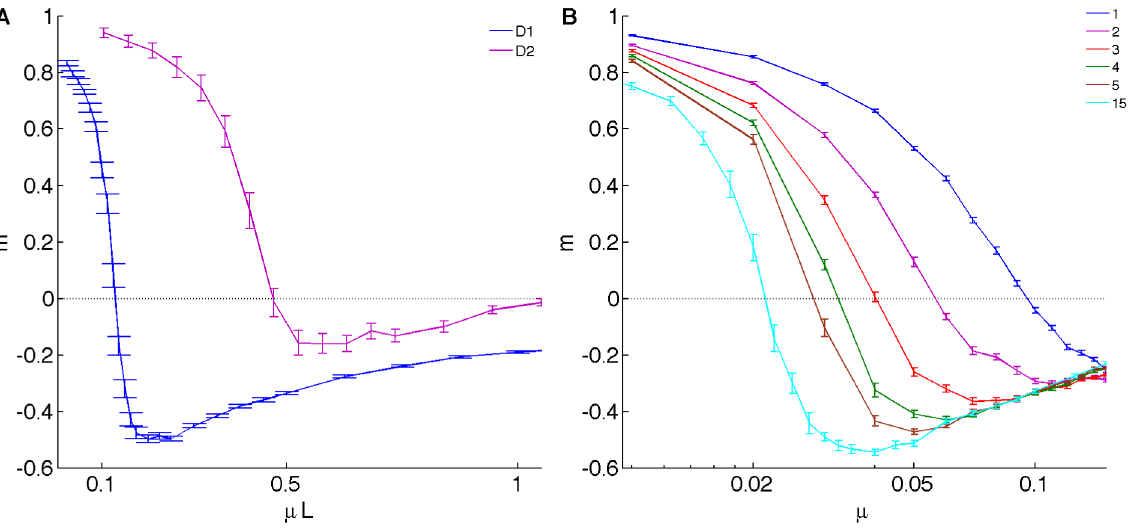
Figure 5. Order parameter in different environments for spatially-structured populations. ( A ) Phase transition for populations playing with memories of different size as a function of genomic mutation rate m L , where L =5 for memory-one strategies (D1, blue line) and L =21 for memory-two strategies (D2, pink line). ( B ) Phase transition for environments with different resolutions of strategy space, from 15 bits per gene to 1 bit per gene (deterministic strategies). Colors as in legend.